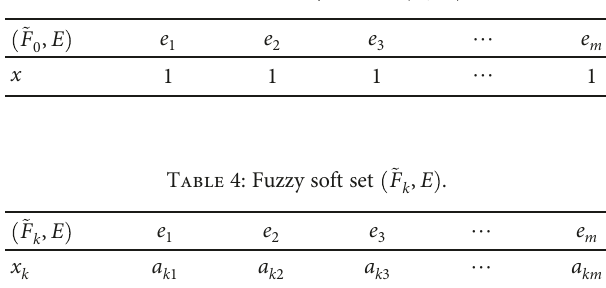
Table 3: Ideal fuzzy soft set F